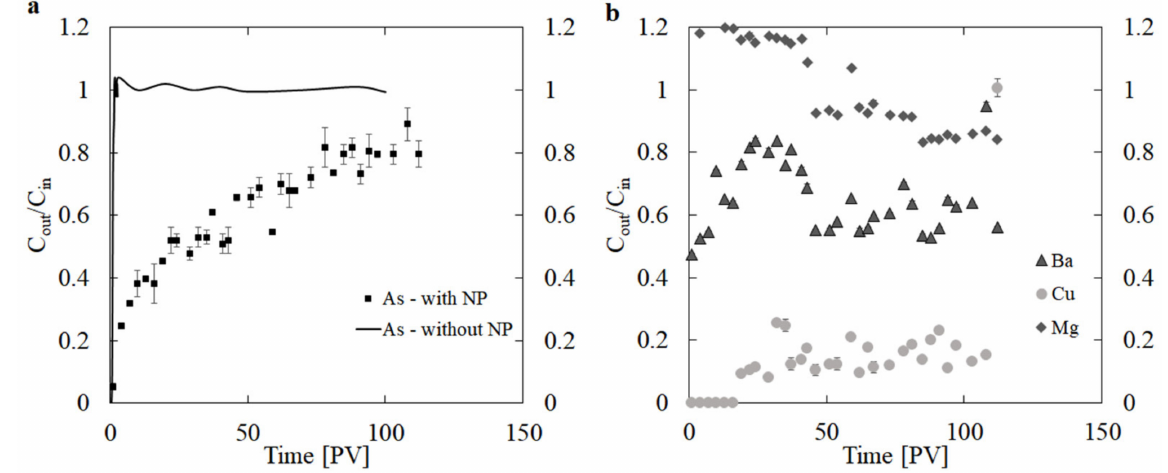
Figure 2. ( a ) Breakthrough curves for arsenic at velocity of 0.375 cm/min with and without addition of Goethite nanoparticles. Inlet concentration (C in ) was 110 µ g arsenic per liter. The x -axis shows the time in pore volumes (PV), where 1 PV equals a contact time of 8 min. ( b ) Breakthrough curves for barium, copper, and magnesium during the same experiments. Data points and error bars depict means and standard deviations of arsenic concentrations from two